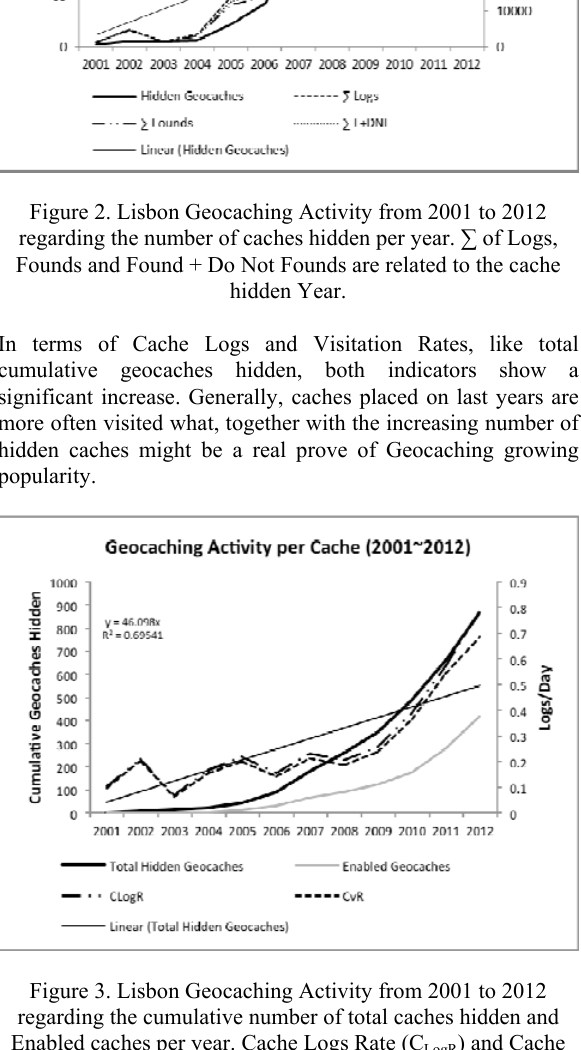
Table 1. Caches percentages and Caches Density within